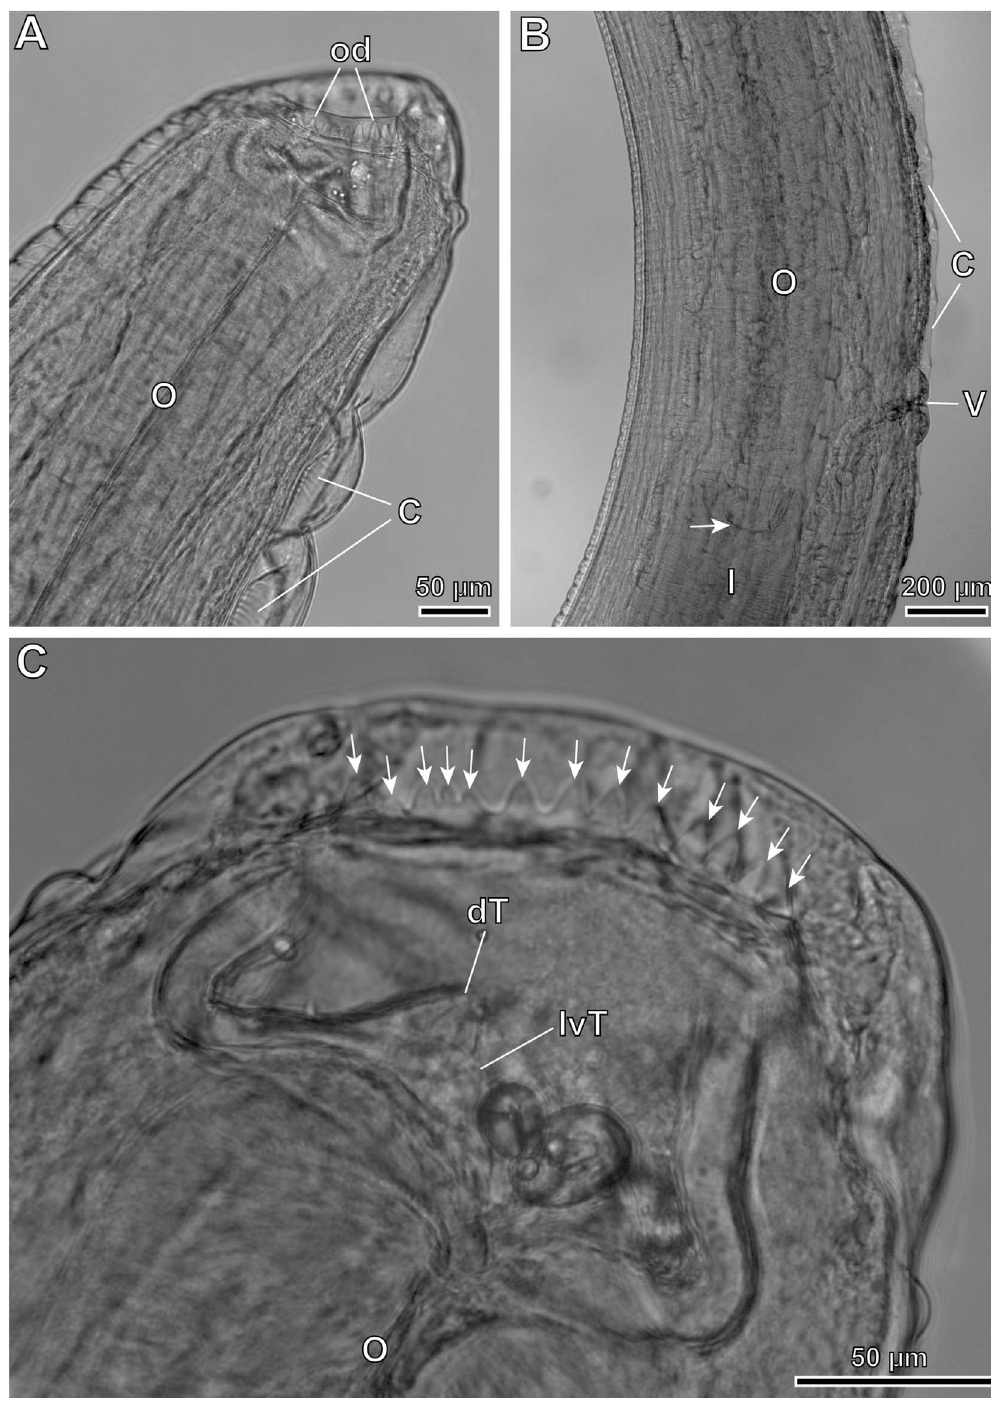
Figure 6. Pterygodermatites ( Mesopectines ) valladaresi n. sp., female, light microscopy. (A) Cephalic extremity, lateral view; (B) vulvar region showing the oesophagus-intestine junction (arrow); (C) buccal capsule showing the oral denticles present in the lateral side (arrows). C, cuticular combs; od, oral denticles; dT, dorsal oesophageal tooth; I, intestine; lvT, lateroventral oesophageal tooth; O, oesophagus; V,